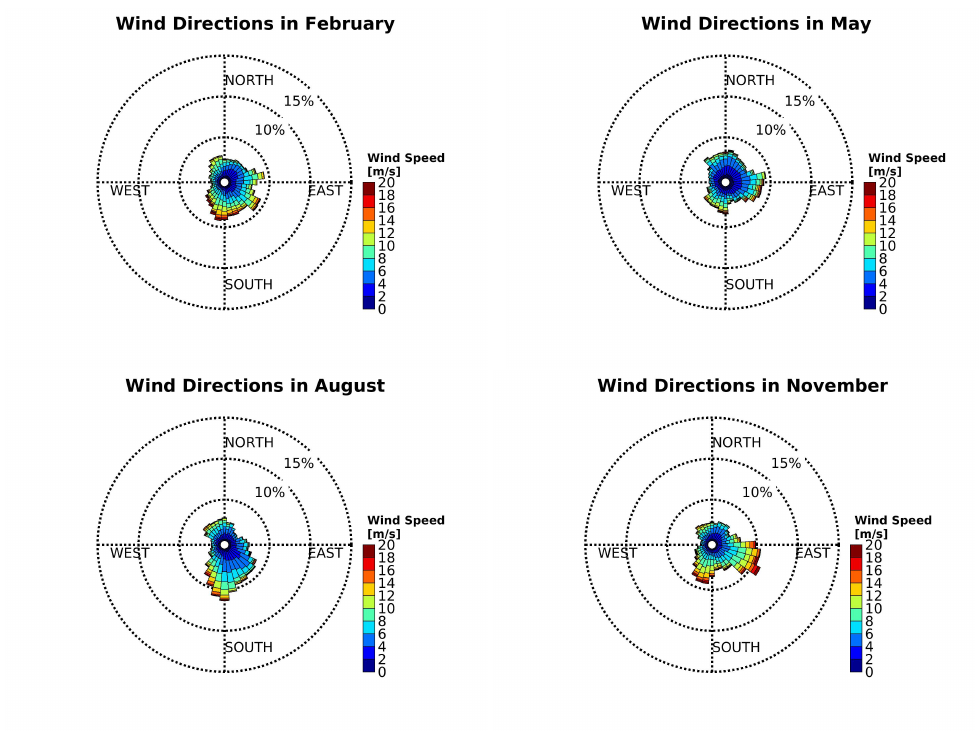
Figure 7. Wind roses at 1000 m altitude in February ( top , left ), May ( top , right ), August ( bottom , left ) and November ( bottom , right ) of the years